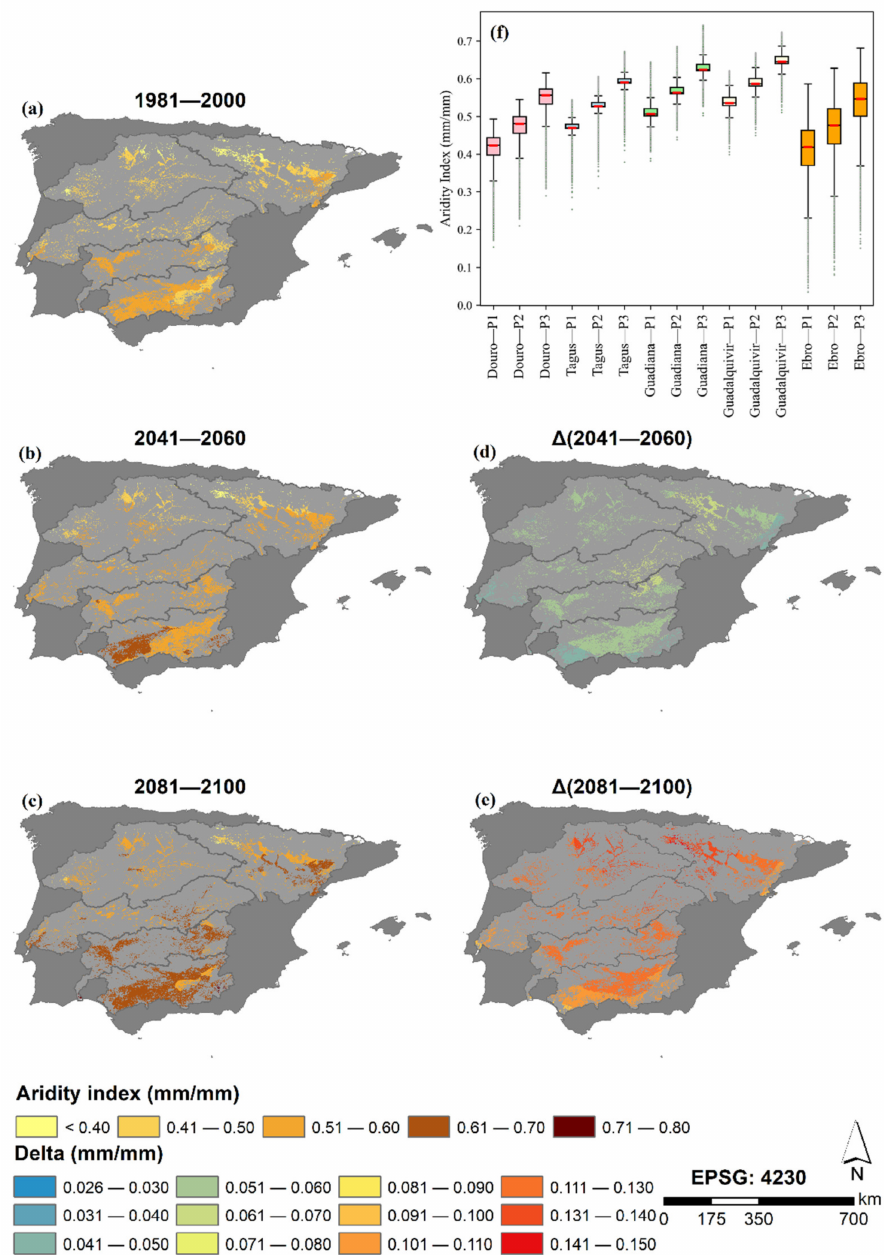
Figure 8. Aridity index (in mm/mm) in water-dependent areas in the Iberian Peninsula for: ( a ) historical period 1981–2000 (P1), ( b ) 2041–2060 (P2), and ( c ) 2081–2100 (P3), ( d ) P2–P1, ( e ) P3–P1, and ( f ) locality, spread, and skewness for each period and river